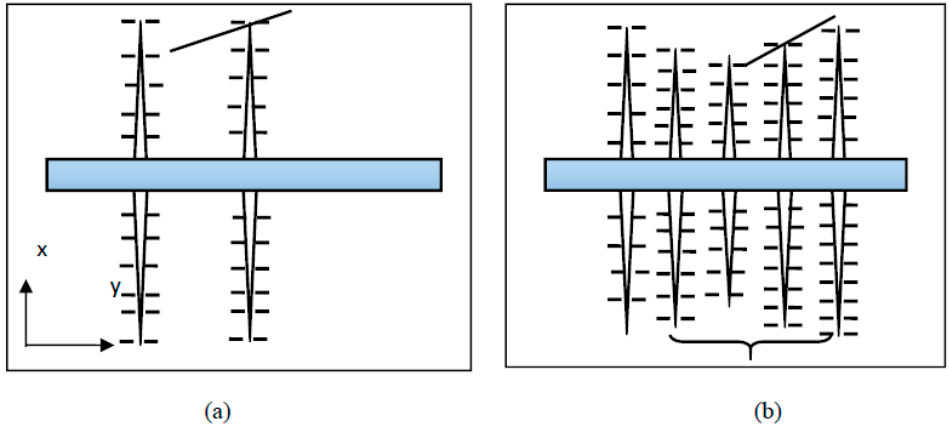
Figure 3. The illustration of discretion of fractures: ( a ) multi-stage fracturing ( b ) multi-cluster